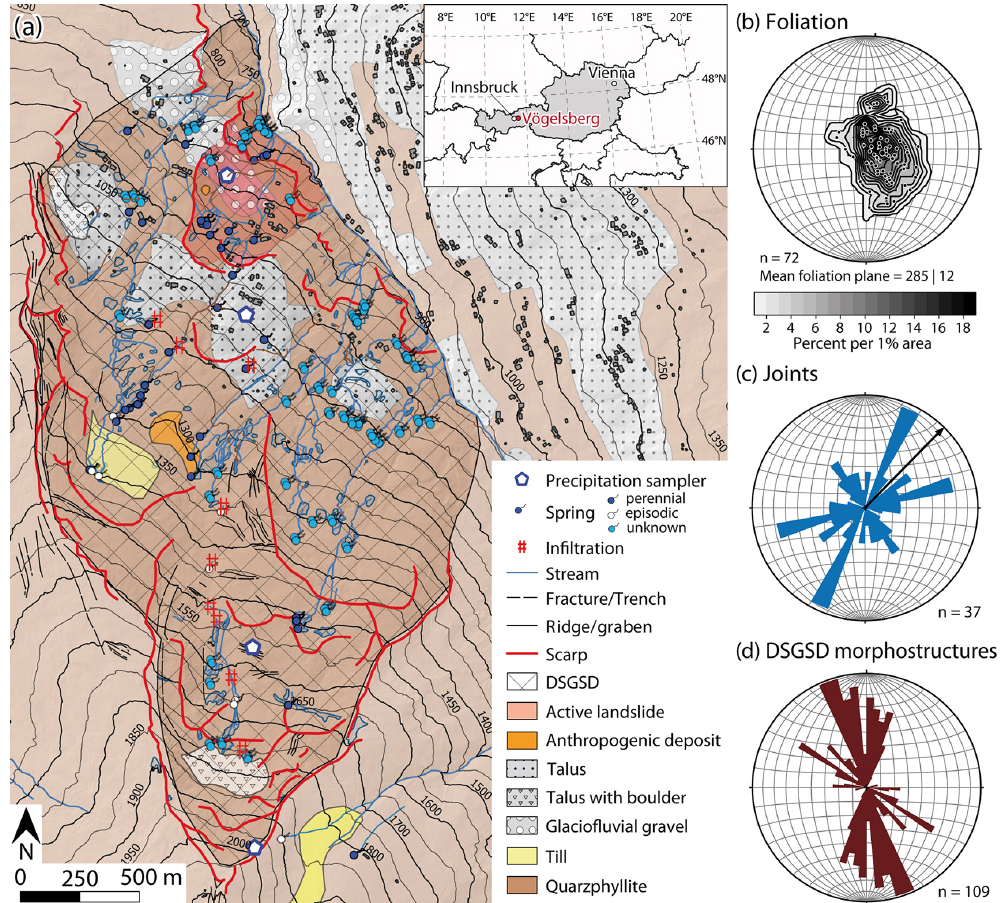
Figure 1. Geological map of the study area (a) , stereographic contour plot of foliation with pole points (b) , and rose plots indicating the orientation of joints (c) and DSGSD morphostructures including scarps, fractures, trenches, ridges, and grabens (d) (DTM and spring inventory: Federal State of Tyrol, geological basemap adapted from